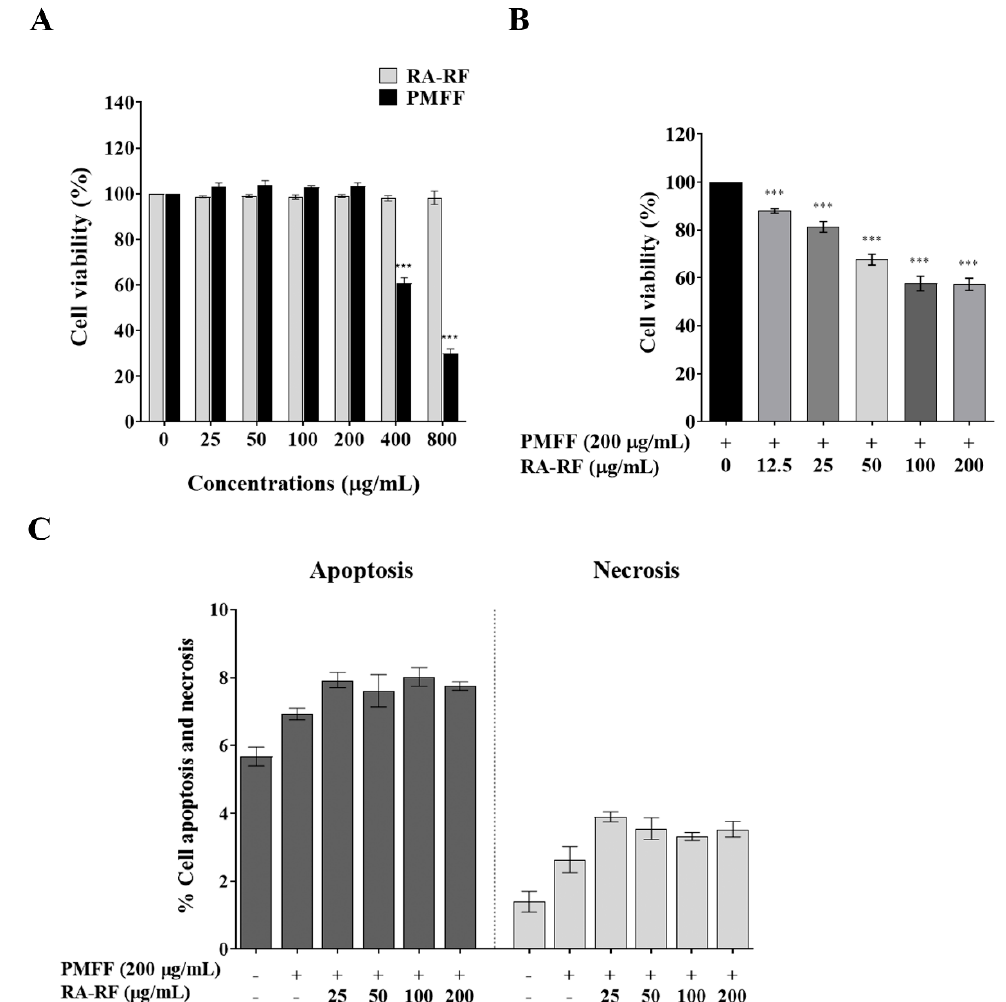
Figure 1. Cell viability of A549 cells treated with different concentrations (0–800 μ g/mL) of the RA-RF or PMFF ( A ) and pre-treated with RA-RF (0–200 μ g/mL) following by adding 200 μ g/mL of the PMFF ( B ). Cell apoptosis and necrosis of A549 cells treated with PMFF (200 μ g/mL) in the presence of RA-RF (0–200 μ g/mL) for 24 h ( C ). The mean ± standard error of the mean (SEM); *** p < 0.001. The data were independently performed in triplicate.